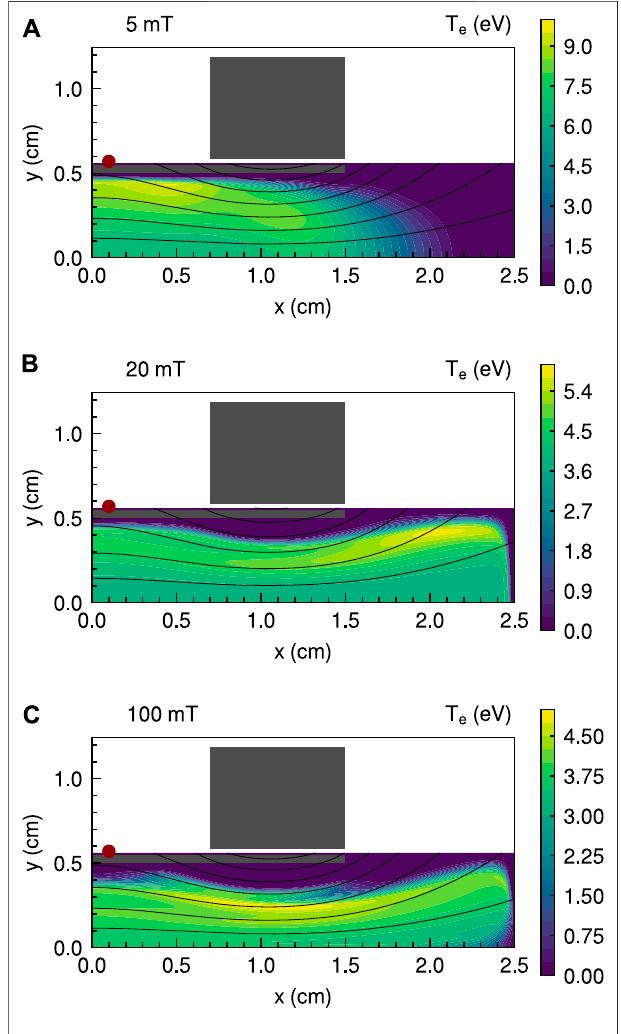
FIGURE 3 | x - y pro fi les of the electron temperature T e for the three magnetic fi eld strengths of (A) 5, (B) 20, and (C) 100 mT. Solid black lines show magnetic fi eld